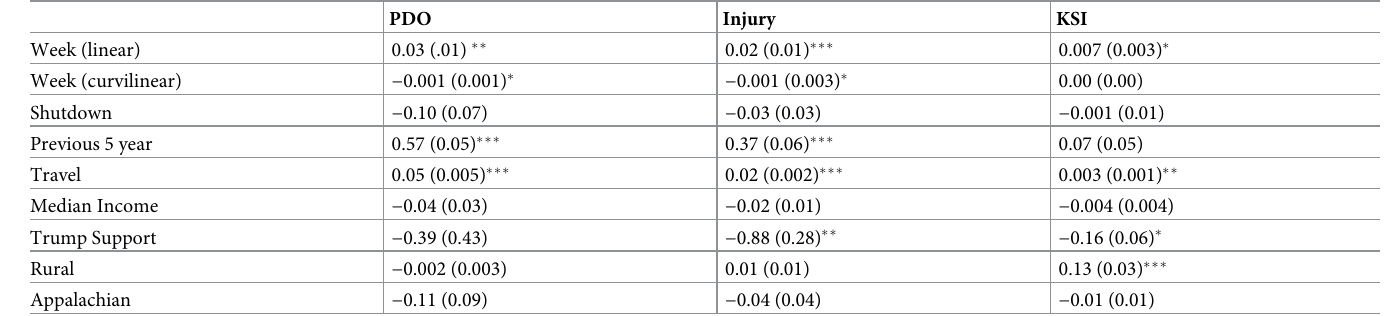
Table 2. Effects of week (linear and curvilinear) and shutdown, controlling for additional